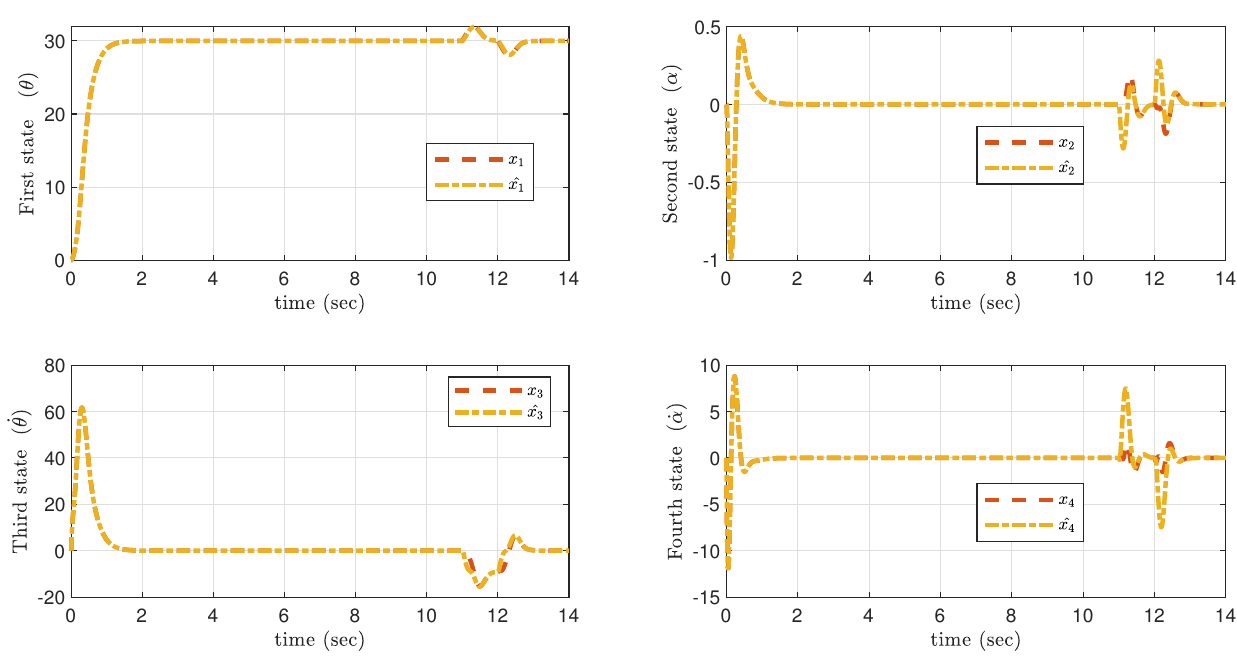
Figure 13. Simulation result of actual and estimated states after reach phase elimination. In order to stress the effect of the difference in real-time control efforts, multilevel fixed set-points trajectory with disturbances is adopted. The servo motor gear angle θ for the selected trajectory is shown in Figure 15. On the zoomed portion, the proposed controller offers a smooth response without overshoot as compared to other techniques, which leads to less chattering in θ . Furthermore, it was also considered to have the desired requirement of less arm end-point deflection ( α ) , and it is observed that the proposed scheme works effectively to satisfy the desired requirement in Figure